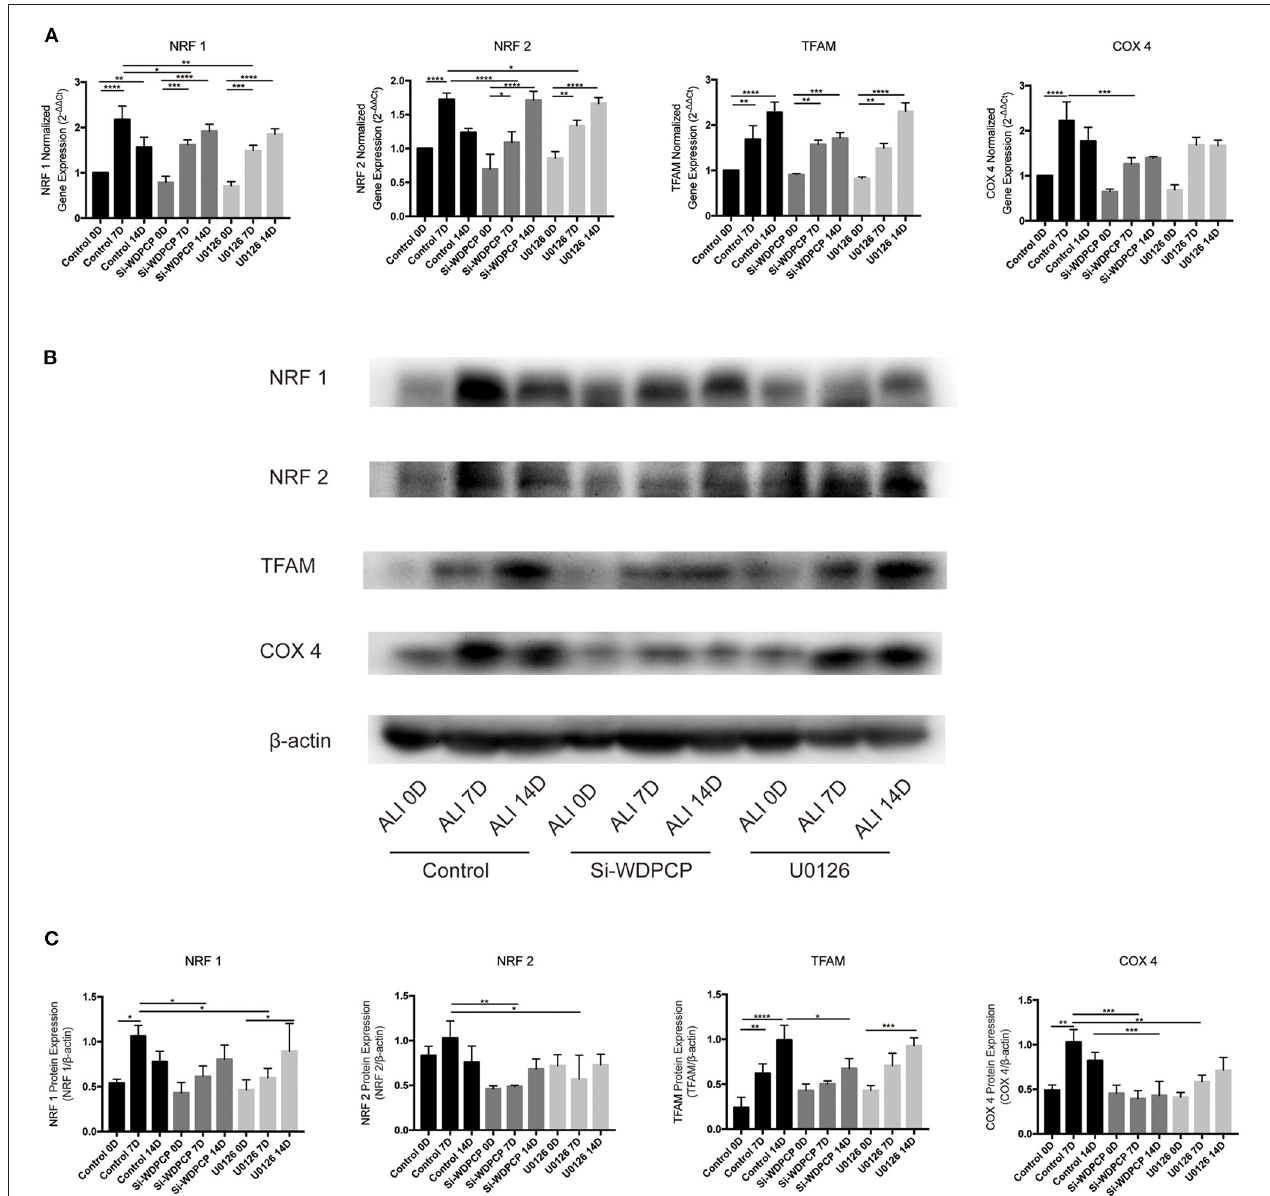
FIGURE 4 | Expression of mitochondrial biogenesis makers in ALI cultures of HSECs. (A) NRF1, NRF2, and COX4 mRNA levels increased over 7 days in ALI cultures, but this increase was lesser in Si-WDPCP HSECs and U0126-treated HSECs. TFAM mRNA levels continued to increase over 14 days in ALI cultures ( n = 3). (B,C) NRF1, NRF2, and COX4 protein levels also increased over 7 days in control ALI cultures, and the expression was decreased in Si-WDPCP HSECs and U0126-treated HSECs on Day-7. TFAM protein levels continued to increase over 14 days in ALI cultures, and its protein expression was decreased in Si-WDPCP HSECs on Day-14 ( n = 3) (* p < 0.05, ** p < 0.01, *** p < 0.001, **** p <